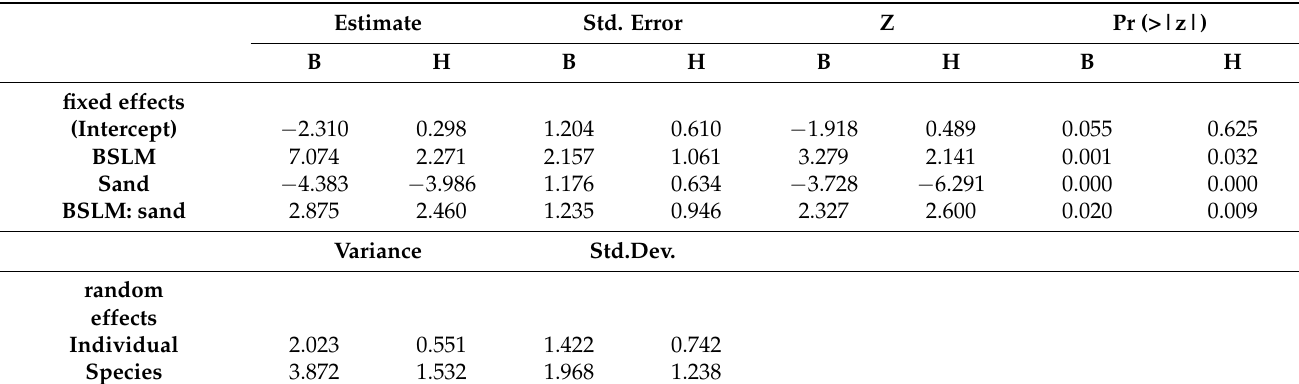
Table 1. Morphotype interacts with substrate type, driving the flight strategy of lacertoid and snake- like lizards. Estimates represent changes in the odds of choosing to burrow or hide with respect to choose running as flight strategy. Burrowing snake-like morphotype (BSLM) exhibit greater odds of burrowing during escape, either on clean sand or in sand covered with leaf litter cover. In turn, clean sand decreases the odds of burrowing or hiding because lacertoids mostly chose those strategies in presence of leaf litter. B = Burrow, H = Hide. Estimate Std. Error Z